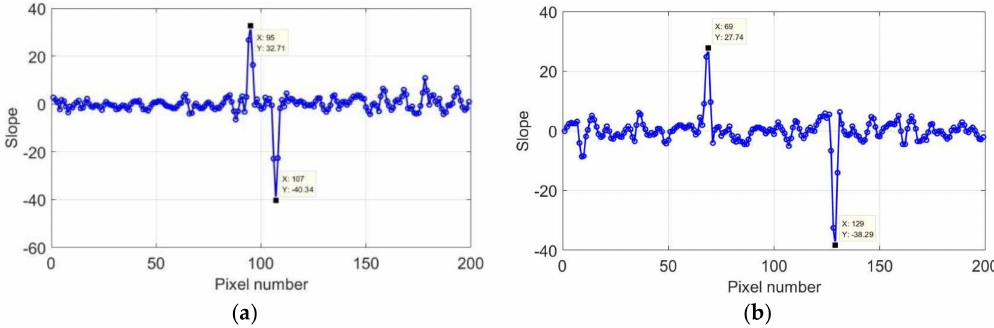
Figure 12. Slope of first derivation of 2 mm at 2 s: ( a ) horizontal and ( b ) vertical direction.